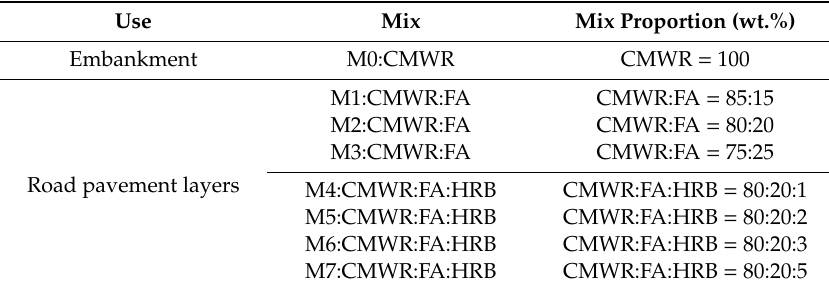
Table 1. Mix proportion of mixes design.